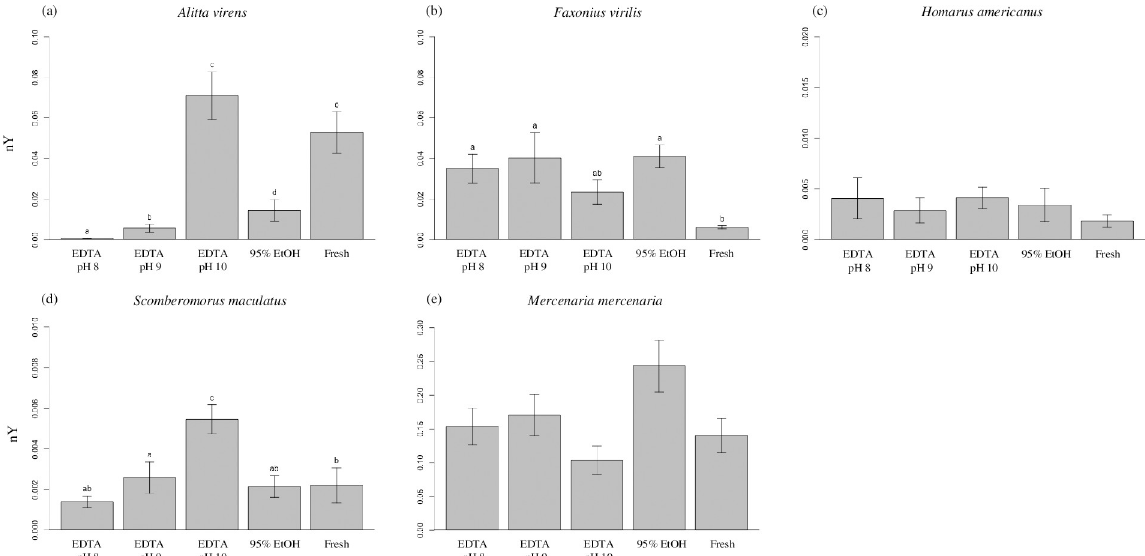
Fig 3. Normalized high molecular weight yield. Average normalized high molecular weight DNA yield (nY; μ g DNA/mg tissue) was determined for tissues of (a) Alitta virens , (b) Faxonius virilis , (c) Homarus americanus , (d) Scomberomorus maculatus , and (e) Mercenaria mercenaria that were extracted either immediately from fresh tissue or stored for 12 months at room temperature in 0.25 M EDTA adjusted to pH 8, 9, or 10, or 95% ethanol. Error bars represent standard error. Within this figure, treatments bearing different lower-case letters are significantly different at the Bonferroni-adjusted p < 0.005; matching lower-case letters indicate statistically indistinguishable treatments; an absence of letters indicates no significant difference among all treatments in a given model. Note that y-axis scales differ among taxa. 95% EtOH, 95% ethanol; Fresh, untreated tissue extracted immediately after